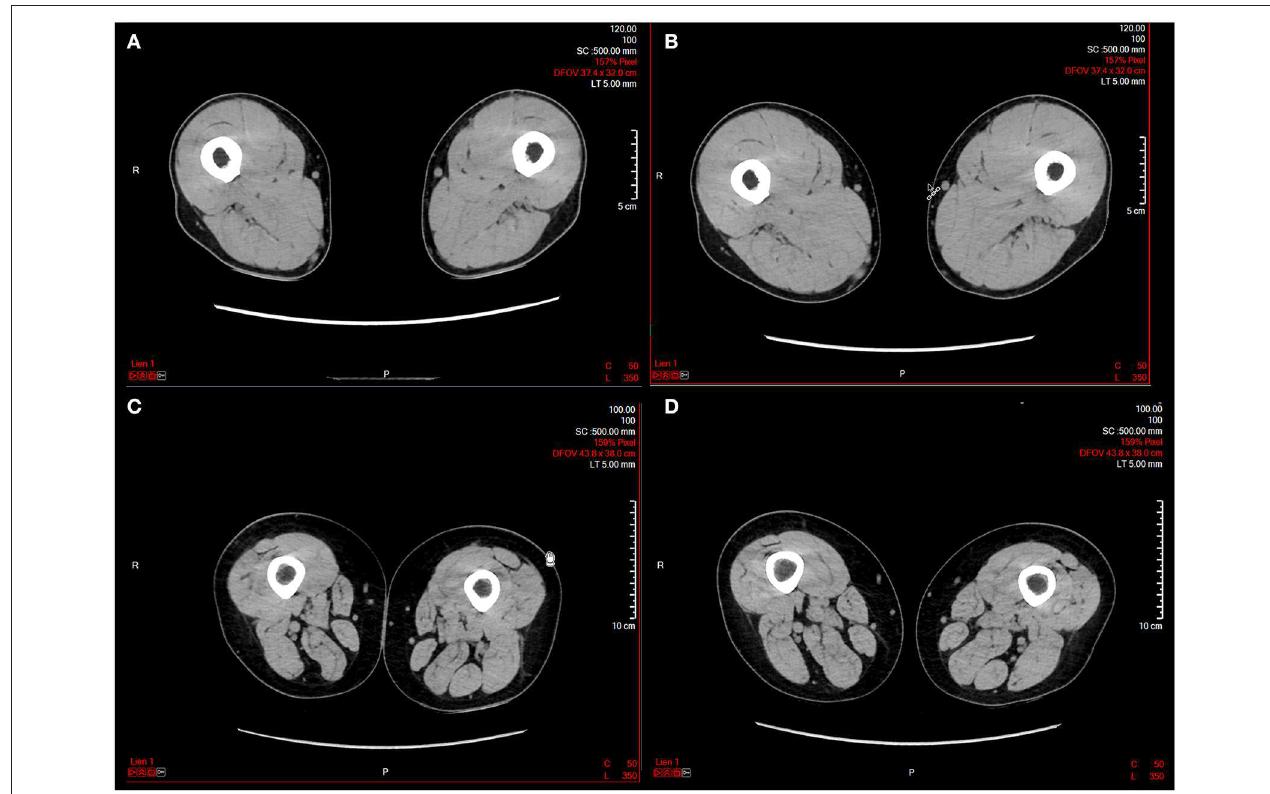
FIGURE 1 | Representative computed tomography (CT) scans before and after a 16 weeks epidural electrical stimulation (EES) protocol in two patients with spinal cord injury. (A) Patient 1 before EES; (B) patient 1 after EES; (C) patient 2 before EES; (D) patient 2 after EES. The images have been kindly provided by Prof. G. Courtine and J.